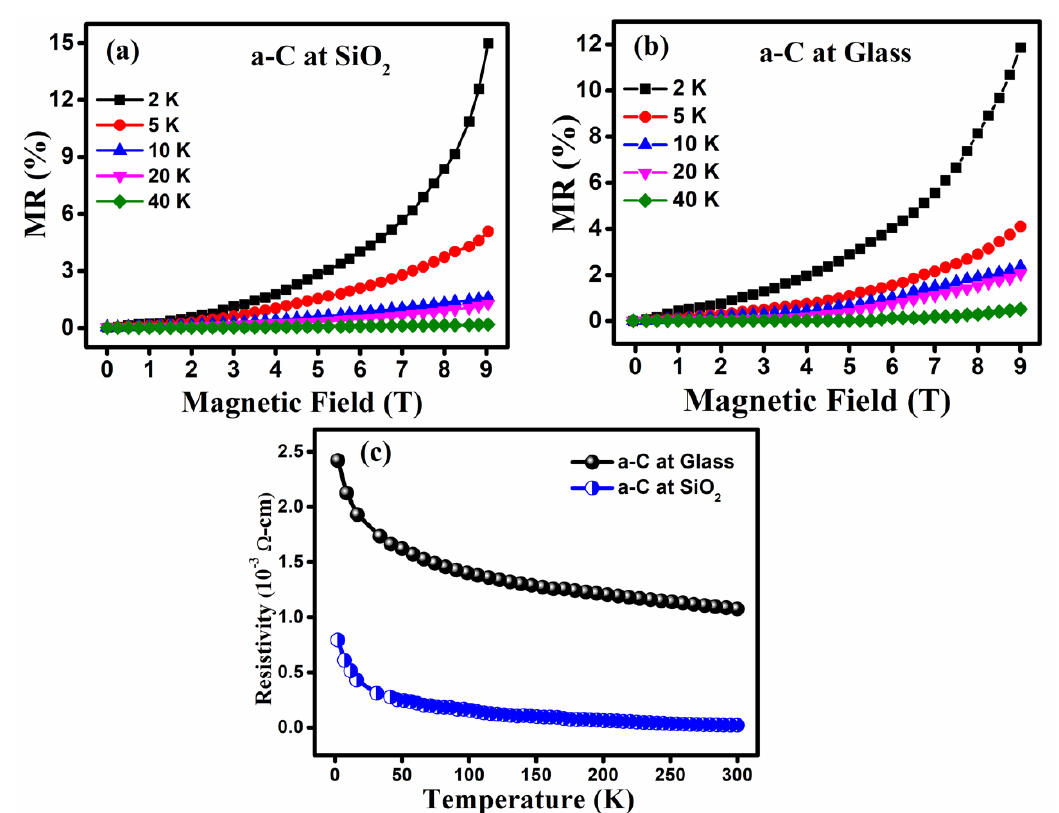
Figure 7. MR vs. magnetic field (T) ( a ) for a-Carbon on SiO 2 substrate; ( b ) a-Carbon on glass substrate; ( c ) resistivity vs. temperature curves.